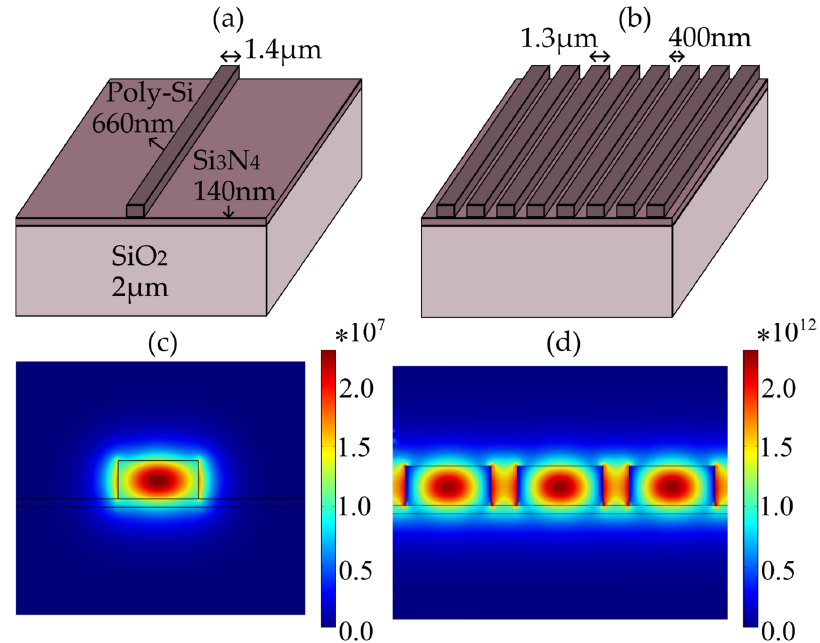
Figure 1. ( a ) Schematics of a strip waveguide compared to ( b ) the investigated CSA waveguides. ( c , d ) Transverse electric field distribution of the fundamental quasi ‐ TE mode as retrieved from FEM simulations for the waveguide dimensions reported in ( a , b ), respectively.